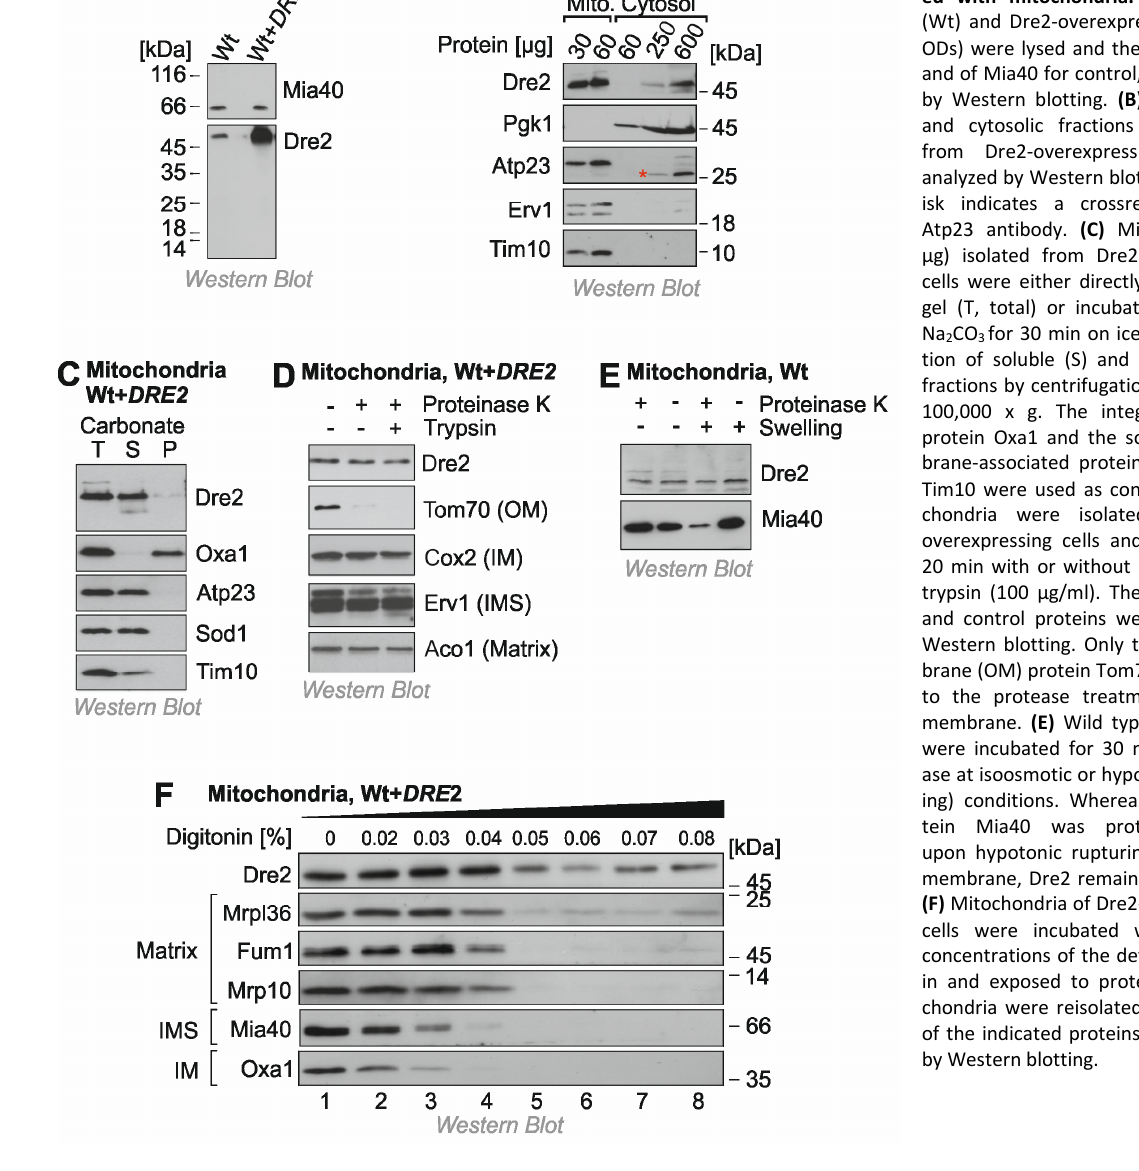
FIGURE 1: A fraction of Dre2 is associat- ed with mitochondria. (A) Wild type (Wt) and Dre2-overexpressing cells (0.5 ODs) were lysed and the levels of Dre2, and of Mia40 for control, were detected by Western blotting. (B) Mitochondrial and cytosolic fractions were isolated from Dre2-overexpressing cells and analyzed by Western blotting. The aster- isk indicates a crossreaction of the Atp23 antibody. (C) Mitochondria (50 µg) isolated from Dre2-overexpressing cells were either directly loaded to the gel (T, total) or incubated with 0.1 M Na 2 CO 3 for 30 min on ice before separa- tion of soluble (S) and membrane (M) fractions by centrifugation for 30 min at 100,000 x g. The integral membrane protein Oxa1 and the soluble or mem- brane-associated proteins Atp23, Sod1, Tim10 were used as controls. (D) Mito- chondria were isolated from Dre2- overexpressing cells and incubated for trypsin (100 µg/ml). The levels of Dre2 and control proteins were assessed by Western blotting. Only the outer mem- brane (OM) protein Tom70 was sensitive membrane. (E) Wild type mitochondria were incubated for 30 min with prote- ing) conditions. Whereas the IMS pro-